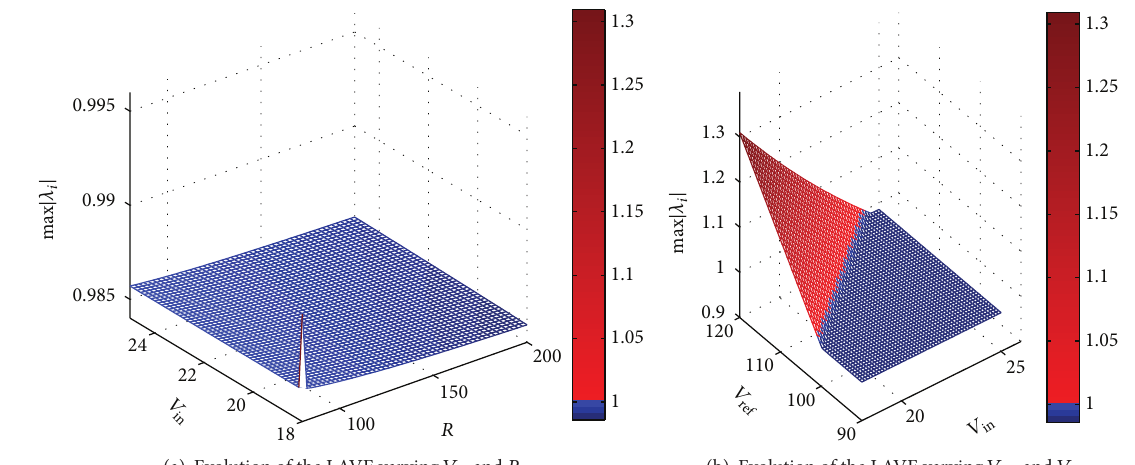
Figure 7: Period-1 orbit stability.